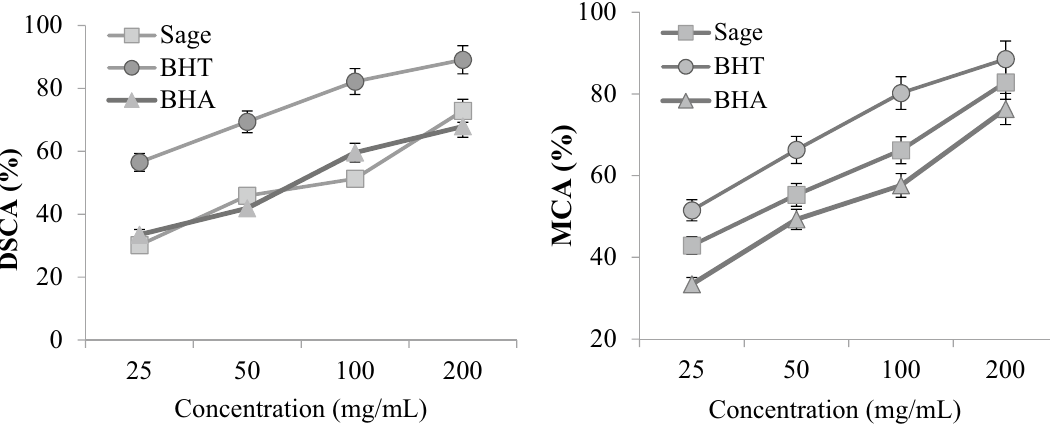
Figure 2. DPPH scavenging (DSCA) and metal chelating activity (MCA) of sage.